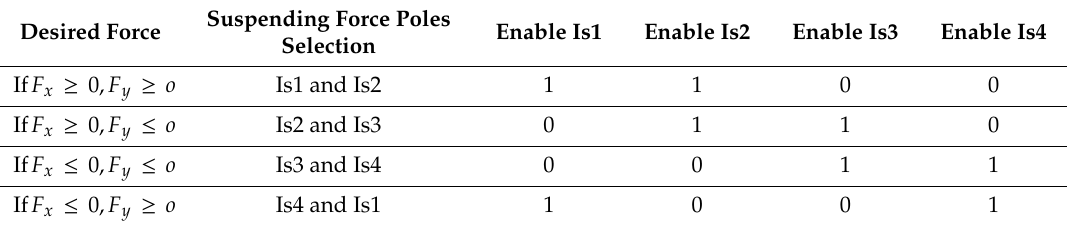
Figure 2. Switching states of the hysteresis control method. Table 3. Switching state rule of the hysteresis control method for the bearingless switched reluctance motor